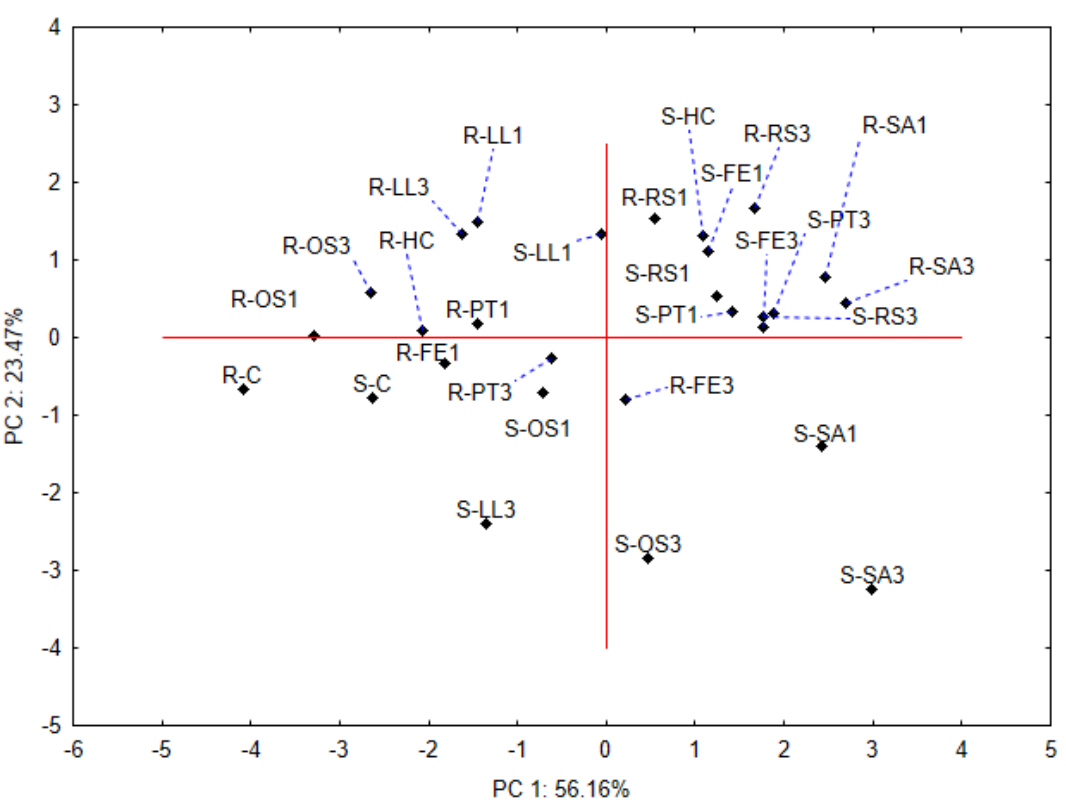
Figure 7. Projection of results of PCA analysis for the growth and physiological traits of biotypes of wild oat with seed meals of different species and at different concentrations in the soil. The individual letters show the order of the tested variants in the space of the first two principal components.